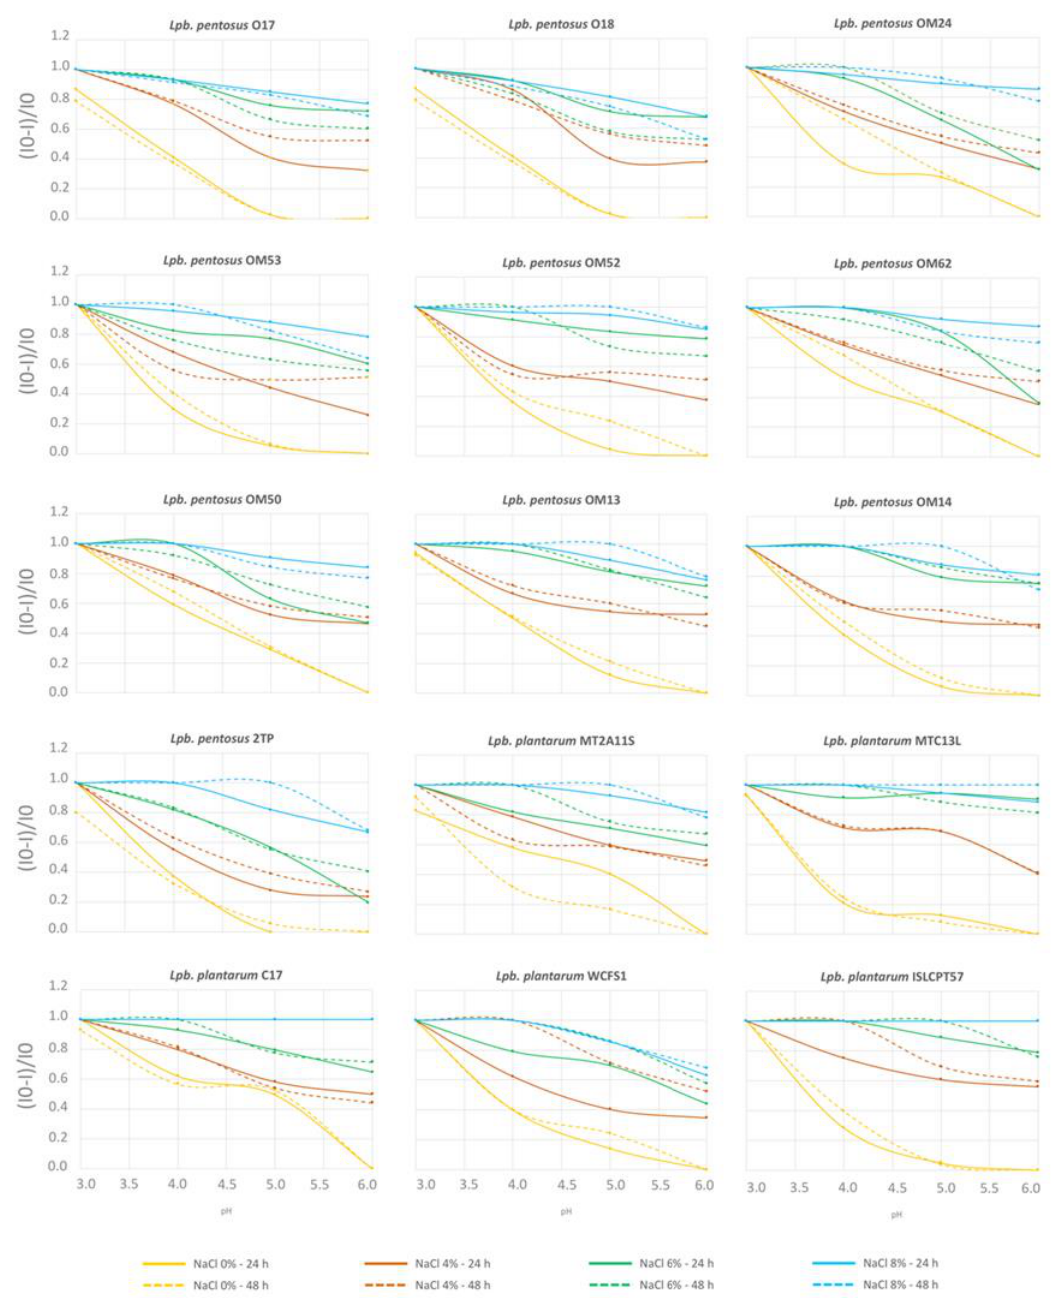
Figure 6. Inhibition curves in response to NaCl concentrations (blue, 8% NaCl; green, 6% NaCl; red, 4% NaCl; orange, 0% NaCl) and pH values (x-axis), after 24 h (continuous lines) and 48 h (dotted lines) of incubation. Inhibition was calculated as (I0-I)/I0, where I0 was the response of the control (i.e., A650 at 0% NaCl and pH 6.0) and I is the response at any given concentration of salt and pH